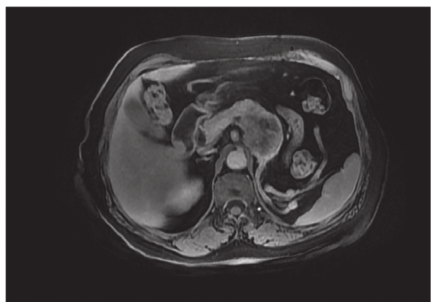
Figure 3: MRI T2 images of a heterogeneous hypersignal corporeal pancreatic